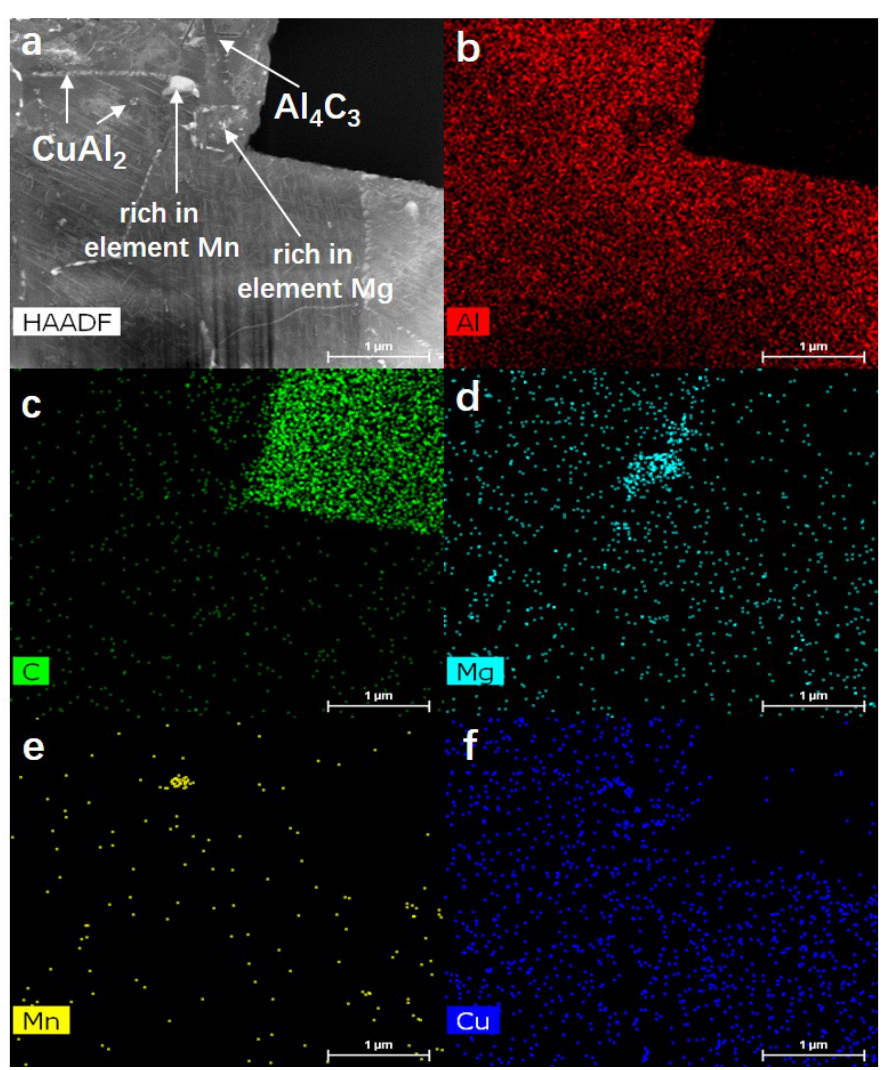
Figure 11. ( a ) HAADF STEM morphology for the interface structure of SCFs/2024 Al composite and the distribution of the corresponding elements for ( b )-Al, ( c )-C, ( d )-Cu, ( e )-Mg, and ( f )-Mn obtained by EDS mapping analysis. Thermal exposure time 0 h.